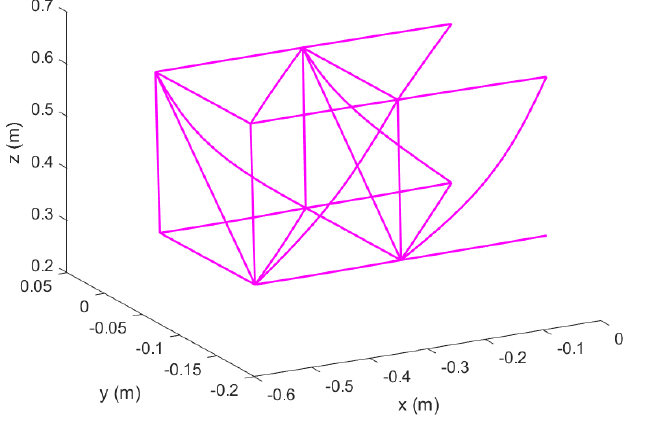
Figure 41. Mode 2 of Timoshenko beams in Topology 2 with hinged ends; original configuration.